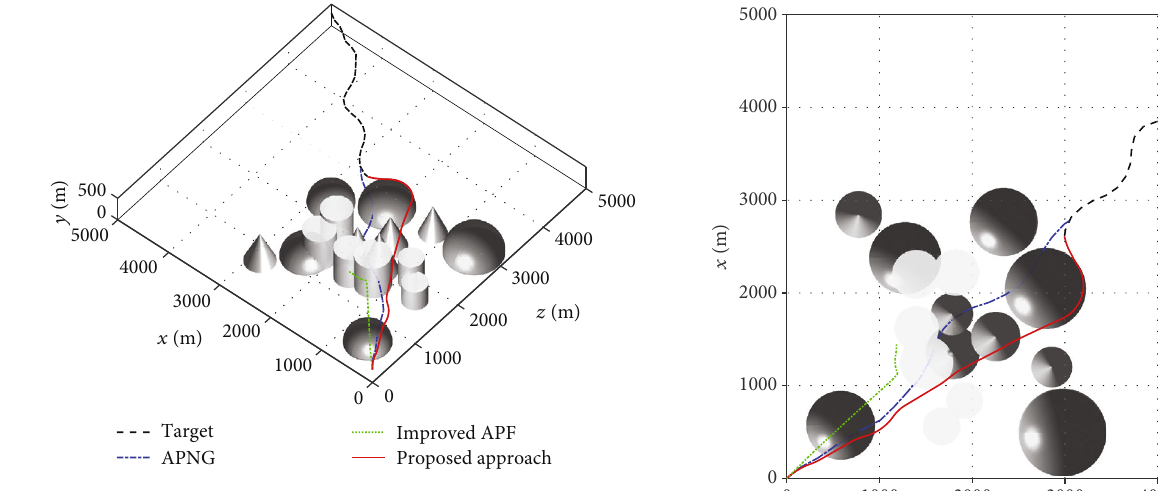
Figure 27: Flight trajectories of interceptor and target in case